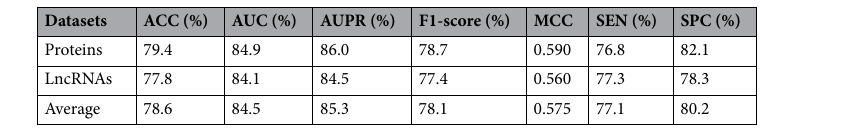
Table 12. Average performance of the proposed prediction system based on protein and lncRNA datasets.